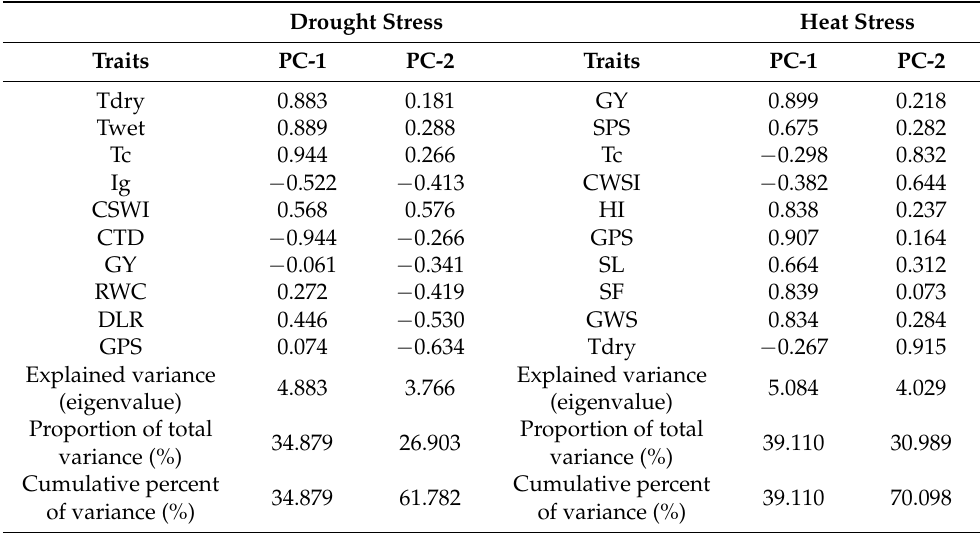
Table 6. Rotated principal component matrix based on the most contributing ten traits for drought and heat stress